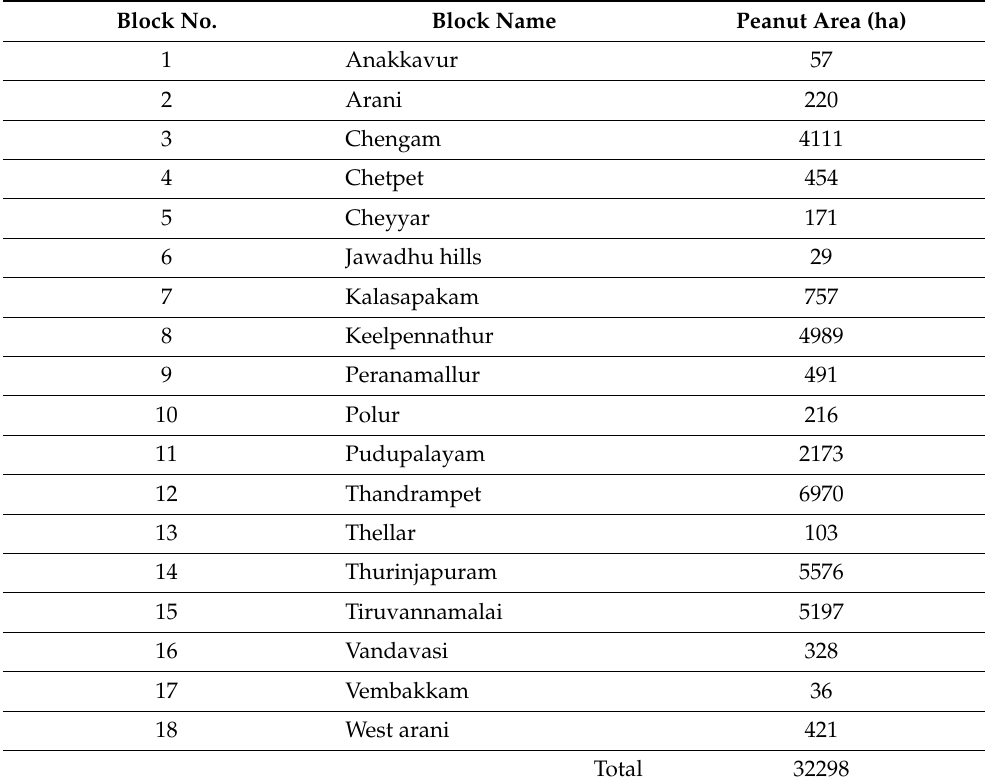
Table 1. Peanut area divided in blocks for the Tiruvannamalai district of Tamil Nadu during Rabi